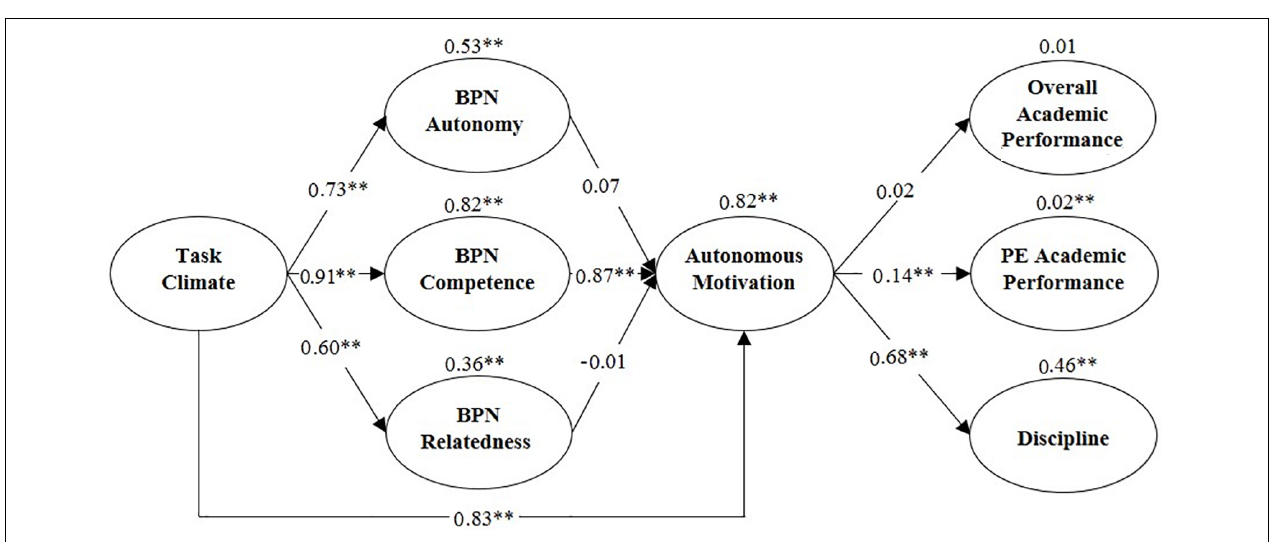
FIGURE 1 | Structural equation model with standardized weights, variances and significance. ∗ Significance level at p < 0.05, ∗∗ significance level at p < 0.01; BPN, basic psychological need; PE, Physical